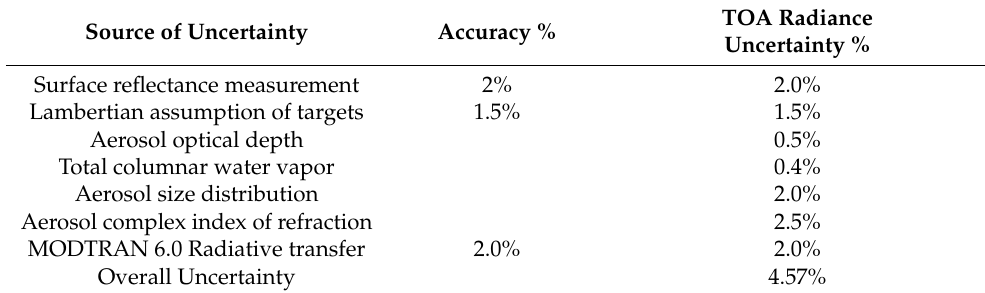
Table 6. Sources of uncertainties in TOA radiance in the reflectance-based approach. Source of Uncertainty